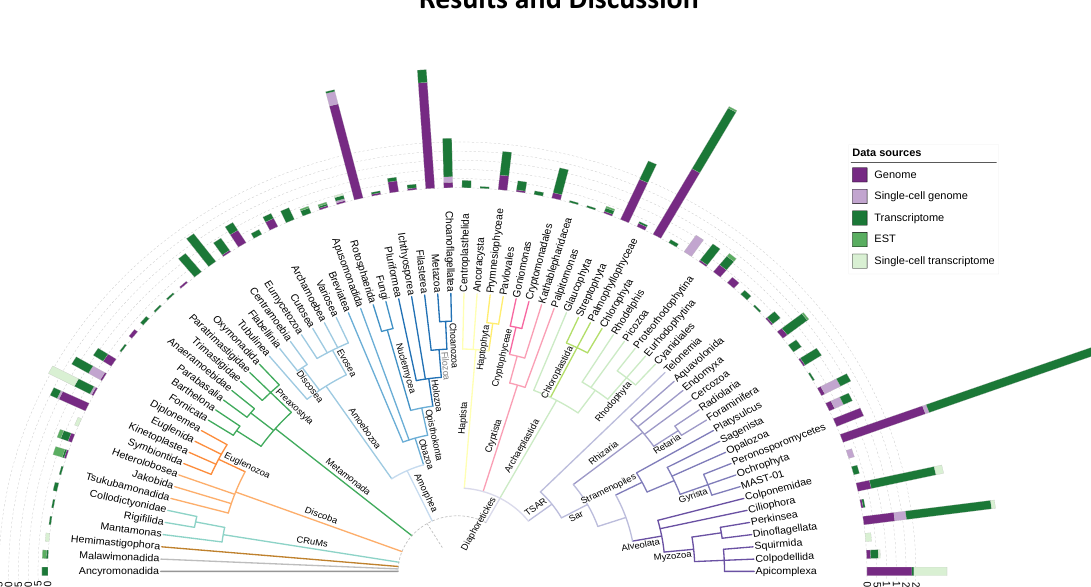
Figure 1 : distribution of 993 source data sets on the eukaryotic tree of life, separated by data set type, with taxonomy based on UniEuk (Berney et al., 2017; Adl et al., 2019). The position of the eukaryotic root, indicated with a dashed line, is currently unresolved. Group names shown in gray are not officially recognized. The figure was created with iTOL (Letunic & Bork,